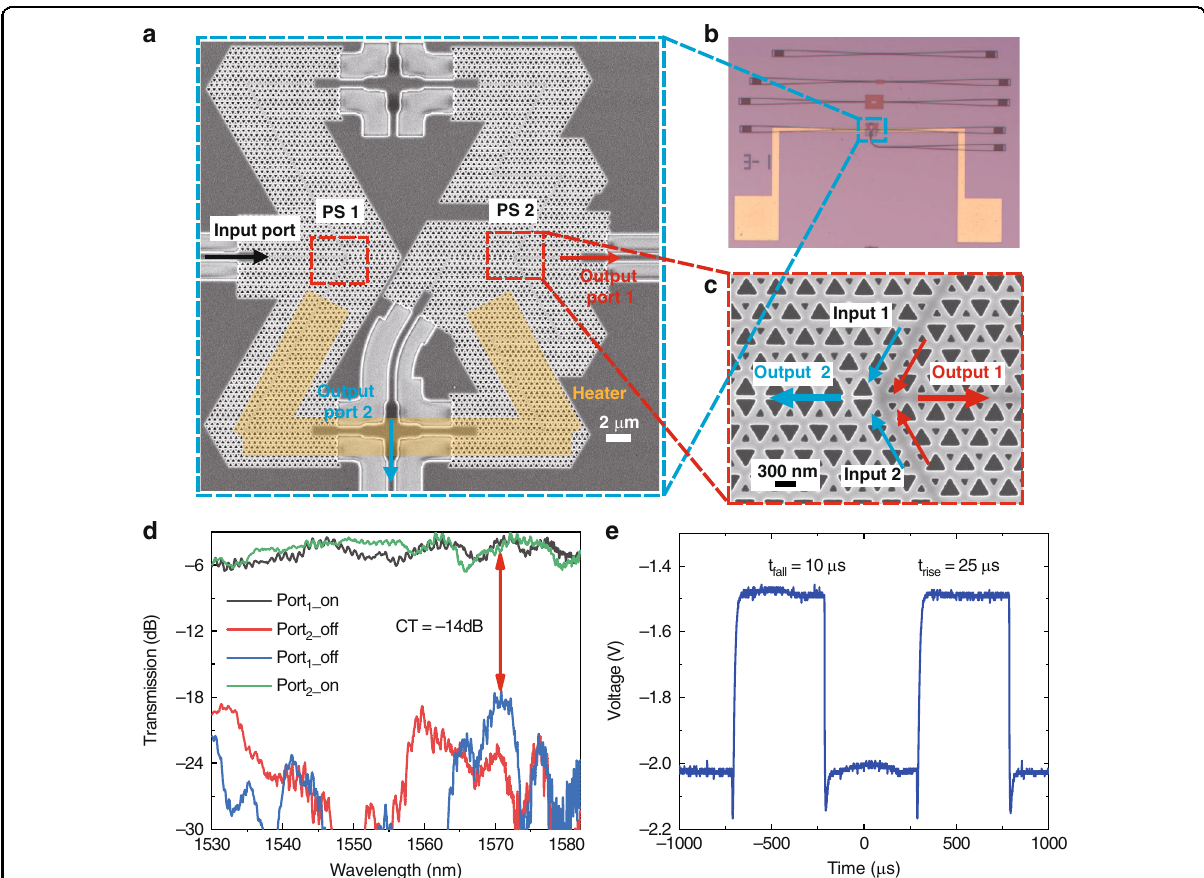
Fig. 3 A topological switch with topologically protected valley edge modes. a Scanning electron microscope (SEM) image and b Microscope image of the topological switch. The orange region in the a represents the “ Heater ” . c SEM image of PS2. d Normalized transmission spectra of the fabricated topological switch. e Temporal responses of the